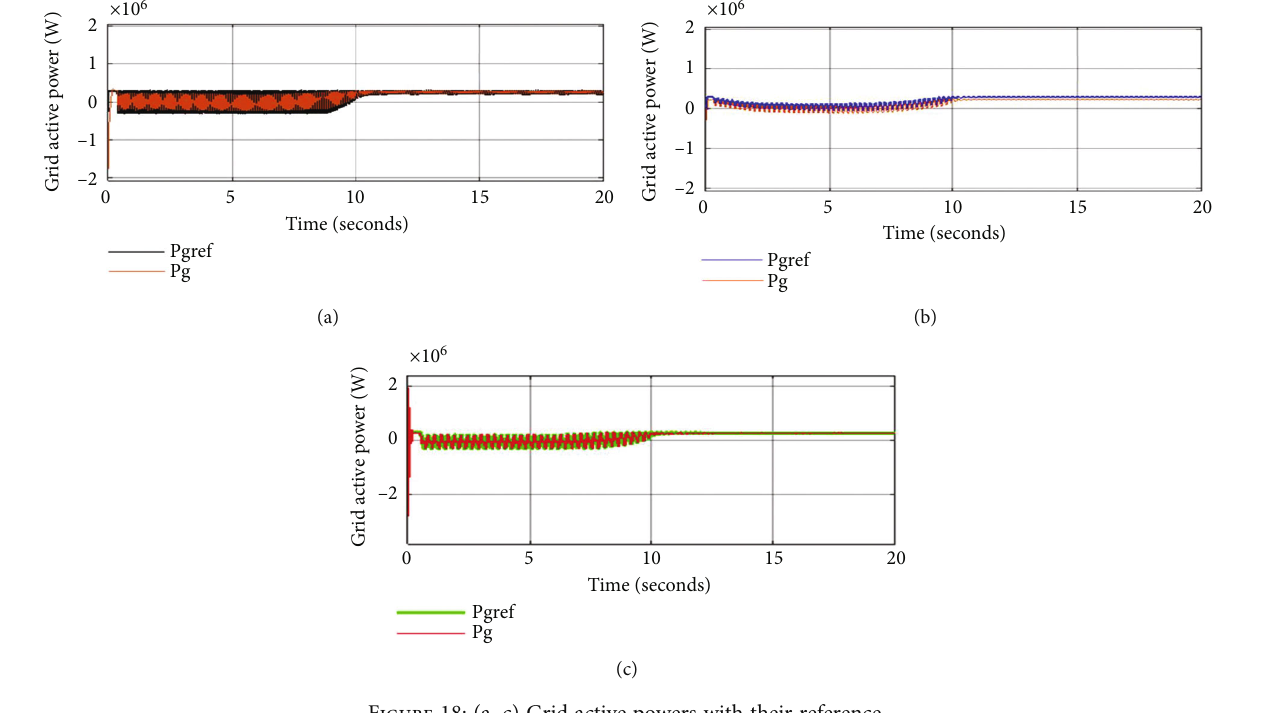
Figure 18: (a – c) Grid active powers with their reference.